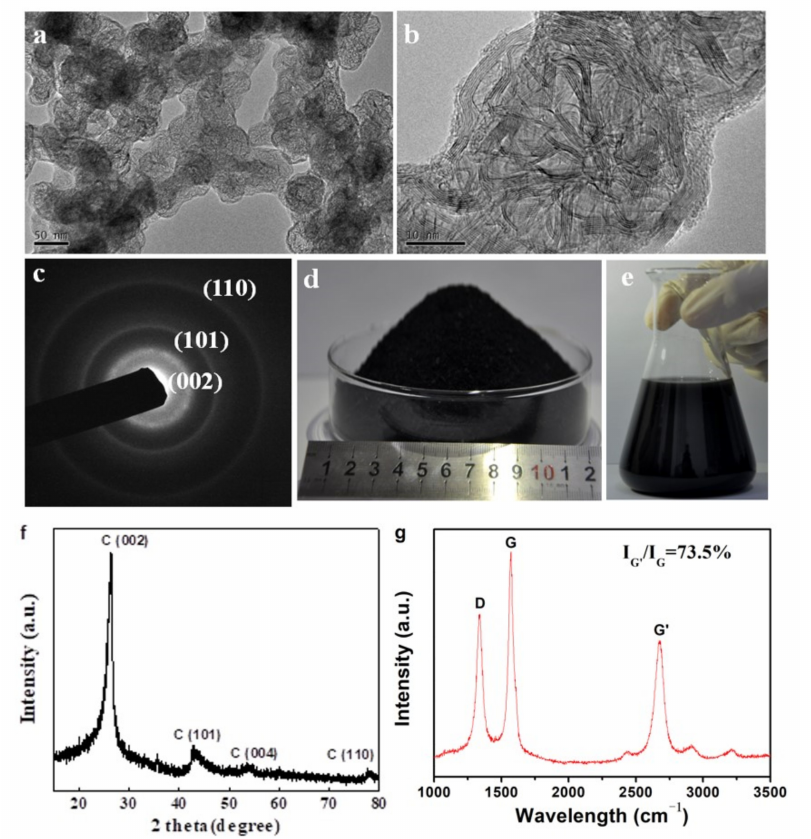
Figure 8. Characterizations of the 3DGNs obtained from SiC − C@graphene nanostructures of sample S6: ( a , b ) Typical TEM images, ( c ) corresponding SAED patterns, ( f ) XRD pattern and ( g ) Raman spectrum. ( d ) Photos of the mass − produced powder. ( e ) Photos of the products dispersed in ethanol after long time placement for one